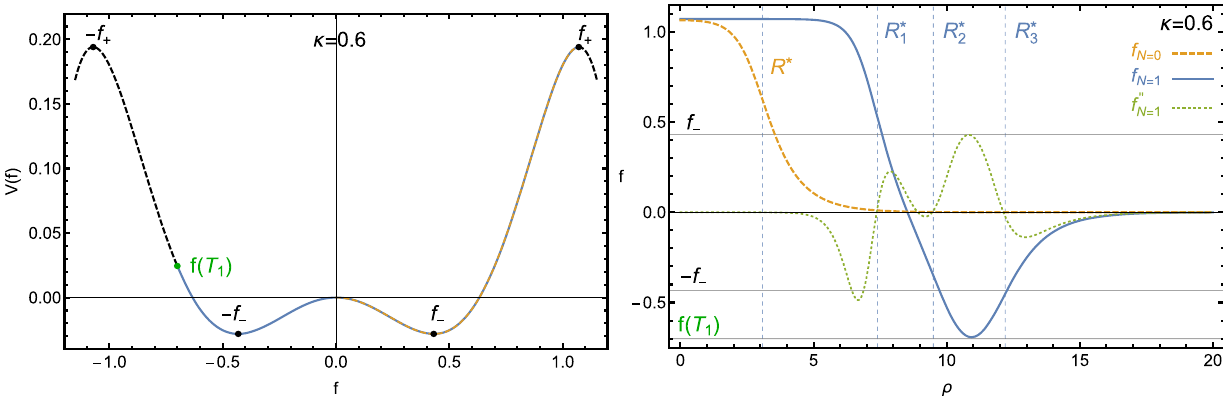
Fig. 2 Effective potential V ( f ) (left) and N = 1 excited state profile f (ρ) (right). The solid line in the potential denotes the path along which the particle rolls. The locations of the relevant extrema of V ( f ) , f ± are denoted in each plot, as is the location of the turning point f ( T 1